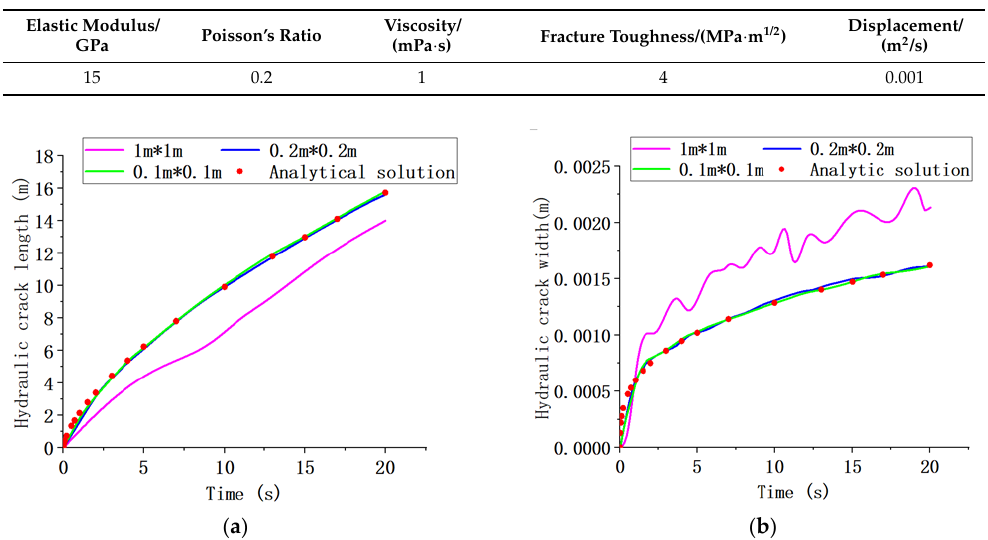
Table 1. Model validation calculation parameters.